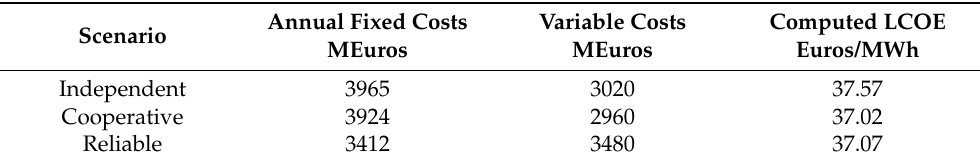
Table 10. Annual expected fixed and variable costs of the thermal technologies in the three optimal scenarios of